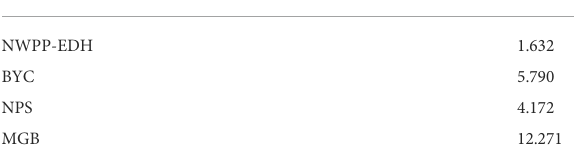
TABLE 3 RMSE indices of the NWPP-EDH, Babin-young-carton (BYC), naval postgraduate school (NPS), and musson gauthier Bruth (MGB)